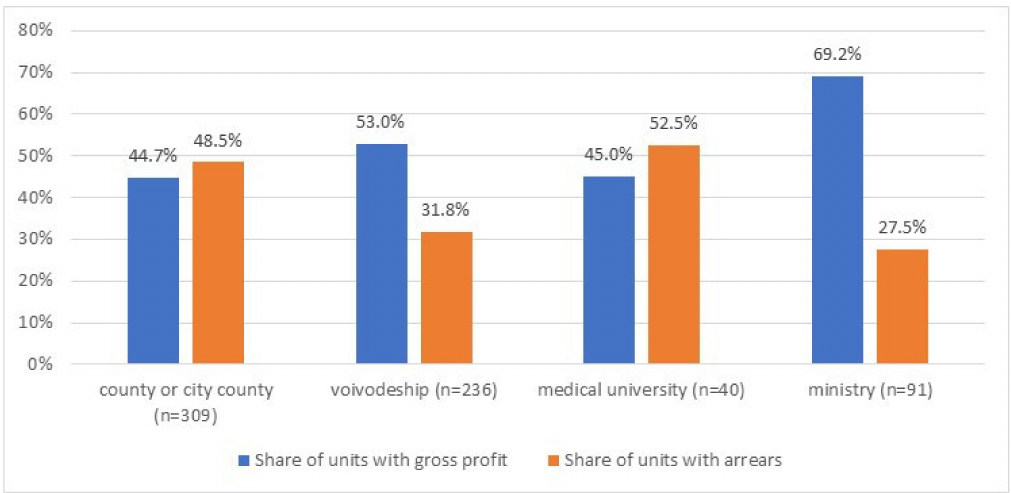
Figure 1. Share of hospitals with gross profit and arrears (%) per ownership groups in 2018. ( p -values from χ 2 test; p -value < 0.001 for both categorical